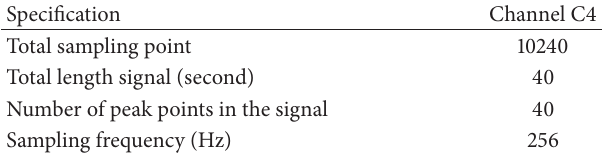
Figure 3: Filtered EEG signal. Table 6: Signal